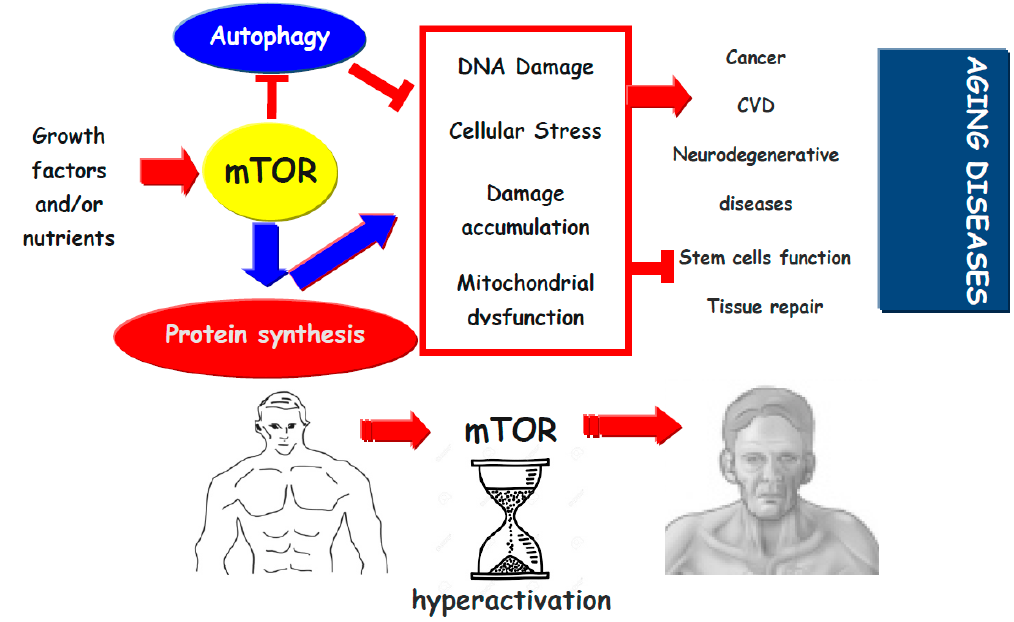
Figure 1. Growth factors and nutrients by activation of mTOR inhibits autophagy and promotes protein synthesis. This may promote cellular stress (protein aggregation, organelle dysfunction, and oxidative stress), which might lead to damage accumulation, reduction in cell function and induces stem cell exhaustion, which reduces tissue repair and promotes tissue dysfunction. Thus, mTor activation pathway promotes the development of aging diseases. (blue and red) indicates activation, indicates inhibition.